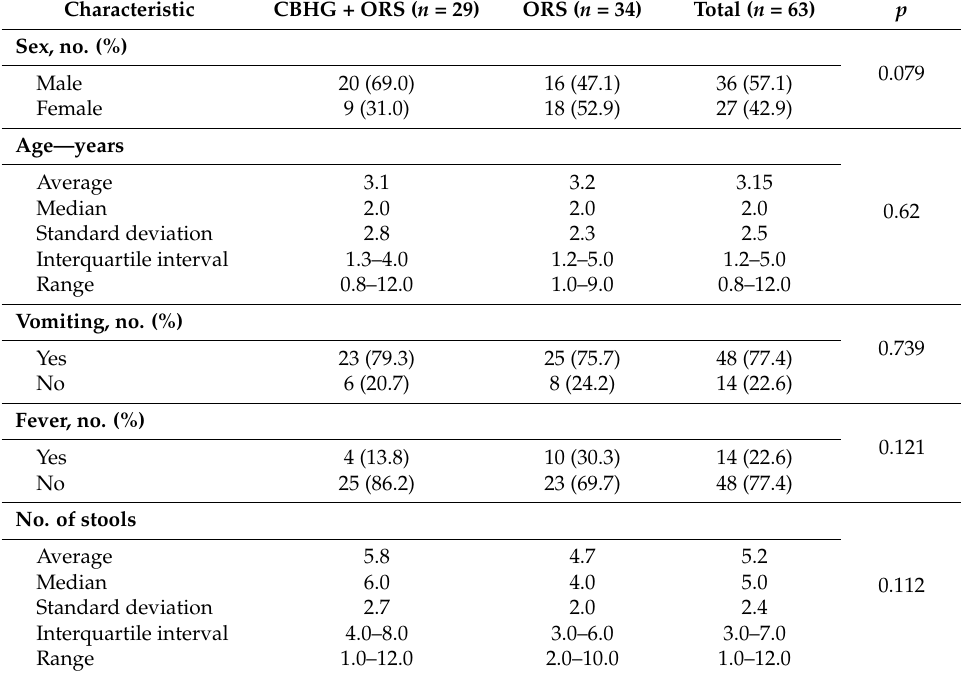
Table 1. Basal demographic and clinical characteristics according to study group.